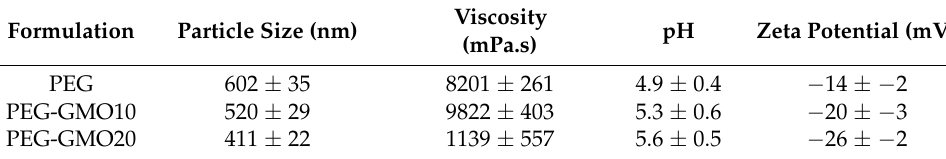
Table 2. Determination of particle size, viscosity, pH, and zeta potential.